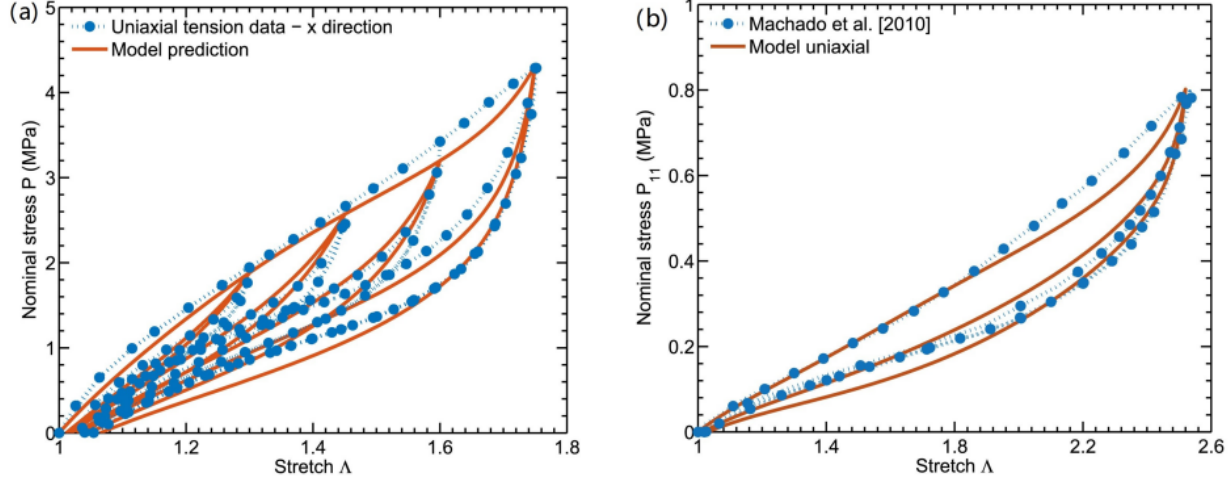
Figure 12. ( a ) Comparison of the experimental data and modeling findings for the cyclic uniaxial tension at various stretch ratios; ( b ) simulation and experimental results [18].